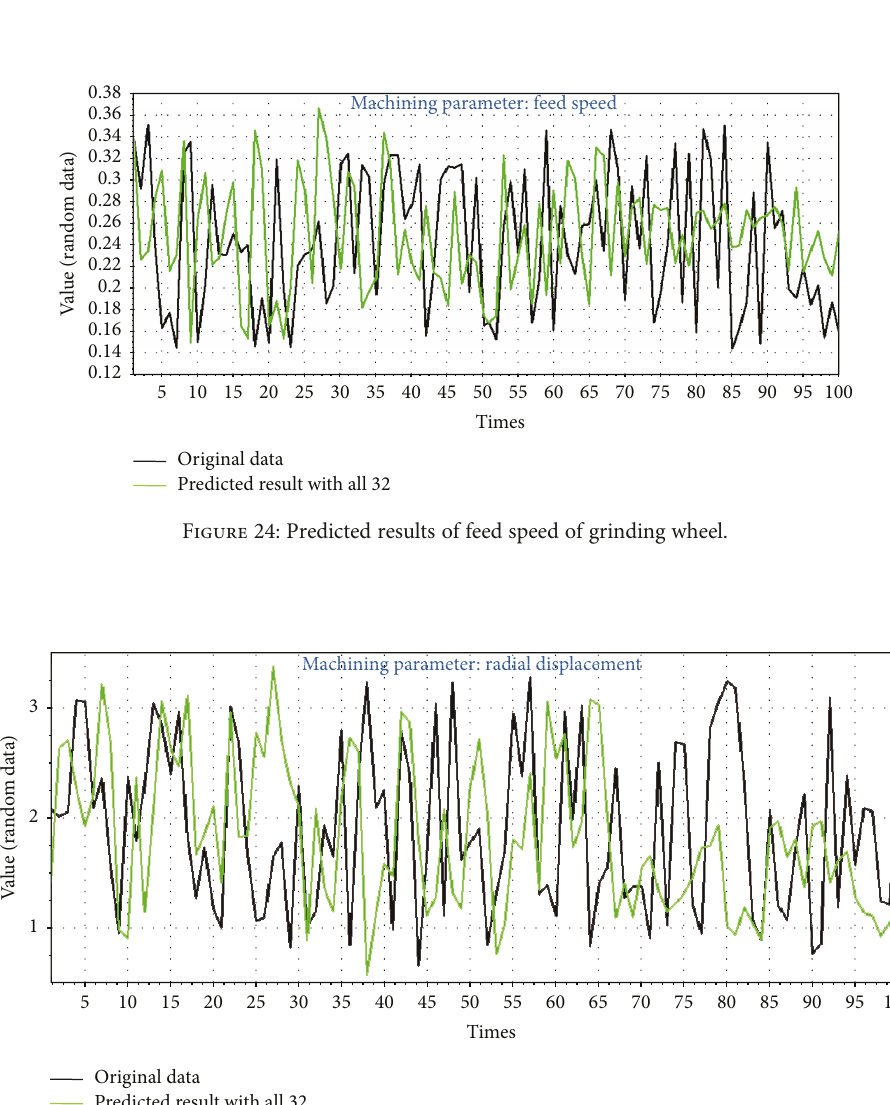
Figure 25: Predicted results of radial displacement of grinding